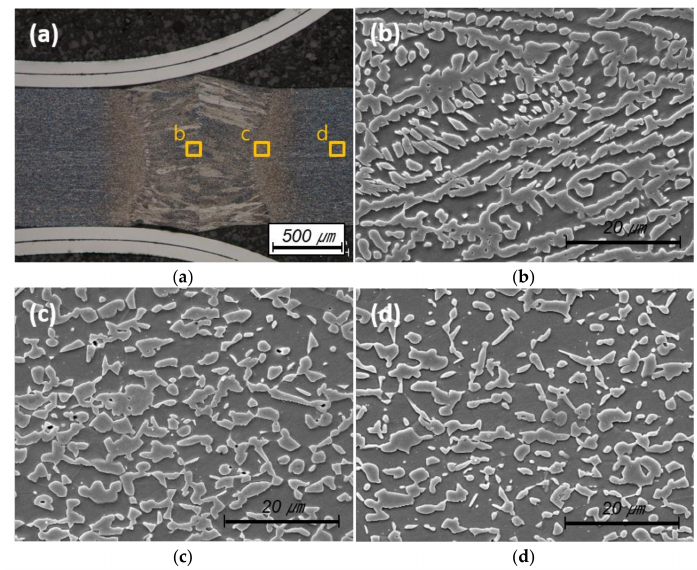
Figure 5. Sectional images of laser welds formed at a laser power of 3 kW and a welding speed of 8 m/min at a 0-mm focal position using a 450-mm focusing optic system (( a ) macrosection, ( b ) fusion zone, ( c ) heat-affected zone, ( d ) base metal).